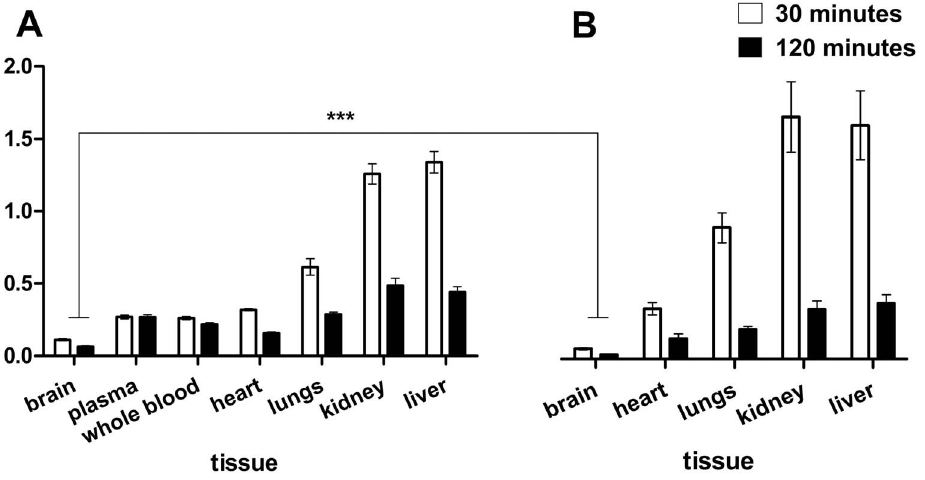
Fig. 4. Percentage of injected [ 125 I]WYE-230949 in different organs of (A) anaesthetised and (B) conscious rats measured ex vivo. *** p , 0.001 compared to anaesthetised